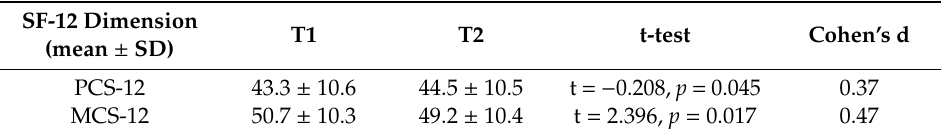
Table 3. SF-12 results. Results display dimensions of SF-12. PCS-12 dimension represents physical aspects of QoL, while MCS-12 represents mental aspects of